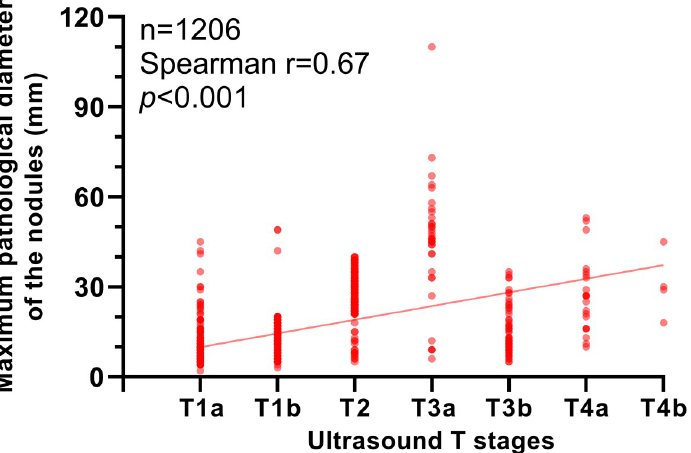
Fig 1. The correlation between maximum pathological diameter of the nodules (mm) and ultrasonic T-stages. https://doi.org/10.1371/journal.pone.0269994.g001 Table 5. The diagnostic value of ultrasonic T-staging compared to pathological T-staging of DTC. Ultrasonic T-stage